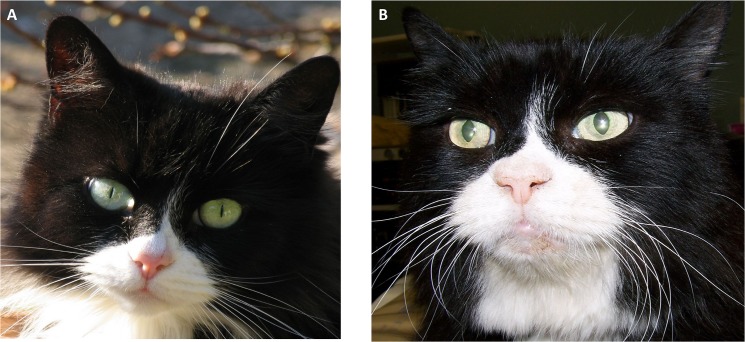
Example of a cat before and after onset of HS-induced changes.Photo a was taken in 2009 and photo b after onset of HS-induced changes in 2012. HS-induced broad facial features are evident in the later picture.